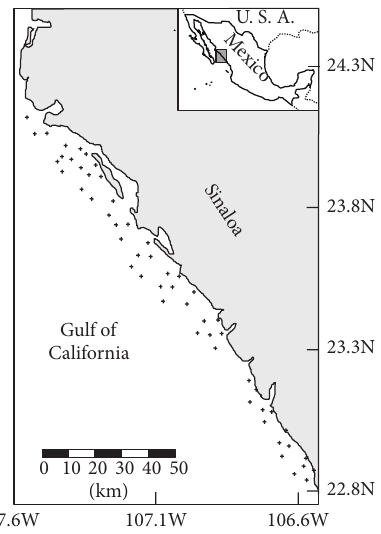
Figure 1: Map of the study area in the southeast Gulf of California, Mexico, and sampling areas (+) where Panama grunt was